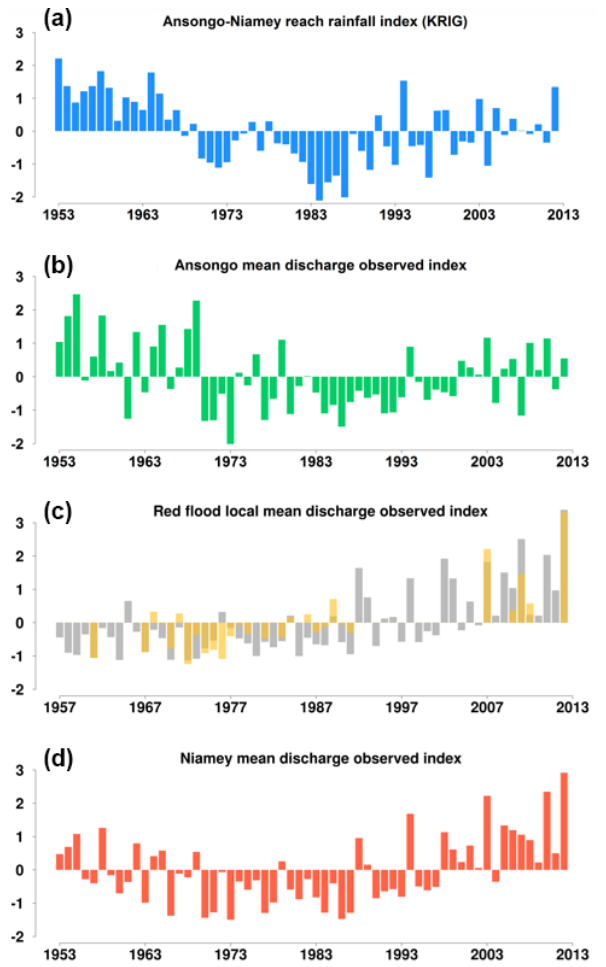
Figure 5. Evolution between 1953 and 2012 of the normalised in- dices of rainfall (a) , red flood period mean discharge in Ansongo (modified after morphing method, see Sect. 2.3) (b) , red flood pe- riod mean differential discharge between Ansongo and Niamey ( c , grey), red flood period mean discharge of the three right bank trib- utaries ( c , yellow) and red flood mean discharge Niamey (d)